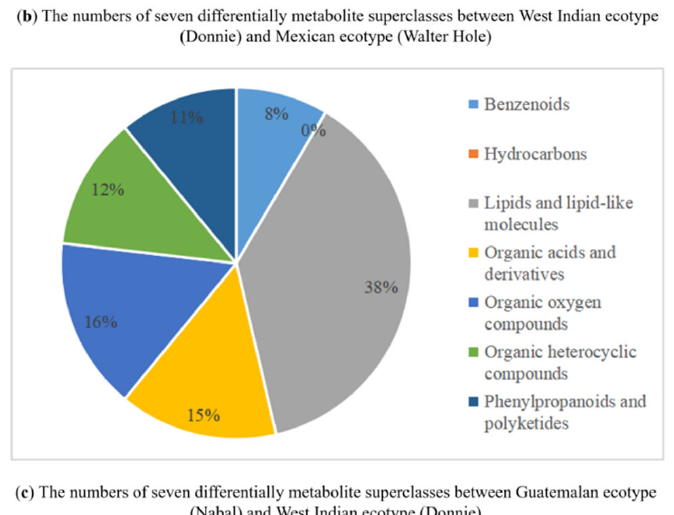
Figure 7. Proportion of differentially accumulated metabolites in seven super-classes among the mature avocado mesocarps of three ecotypes.